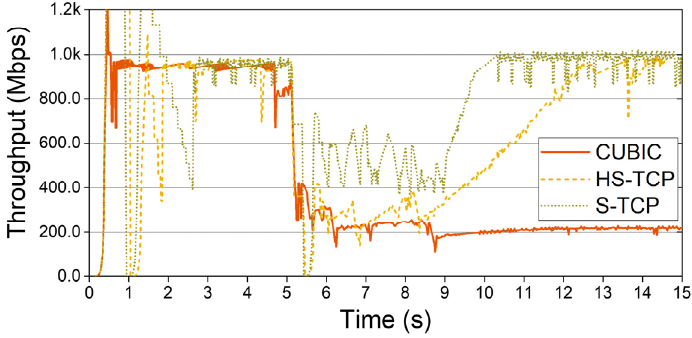
Figure 2. Throughput changes of S-TCP, HS-TCP, and CUBIC TCP.